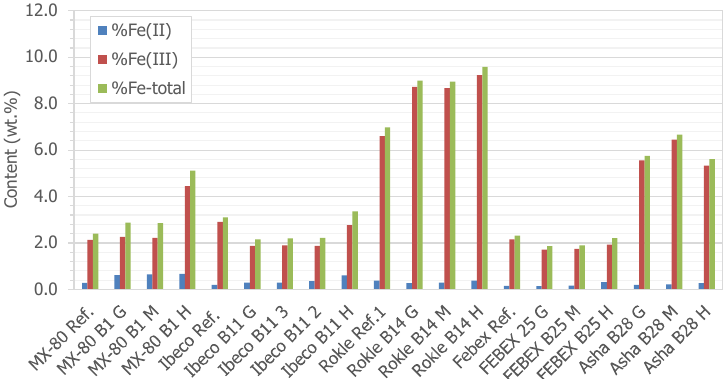
Figure 12. Chemical composition of the solid phase (total fraction) prior to and after the dismantling of the ABM5 experiment as a function of the heater distance (1.70 (H), 5.00 (M) and 8.30 (G) cm). Arrows: variations of content (  : increases or  : decreases).